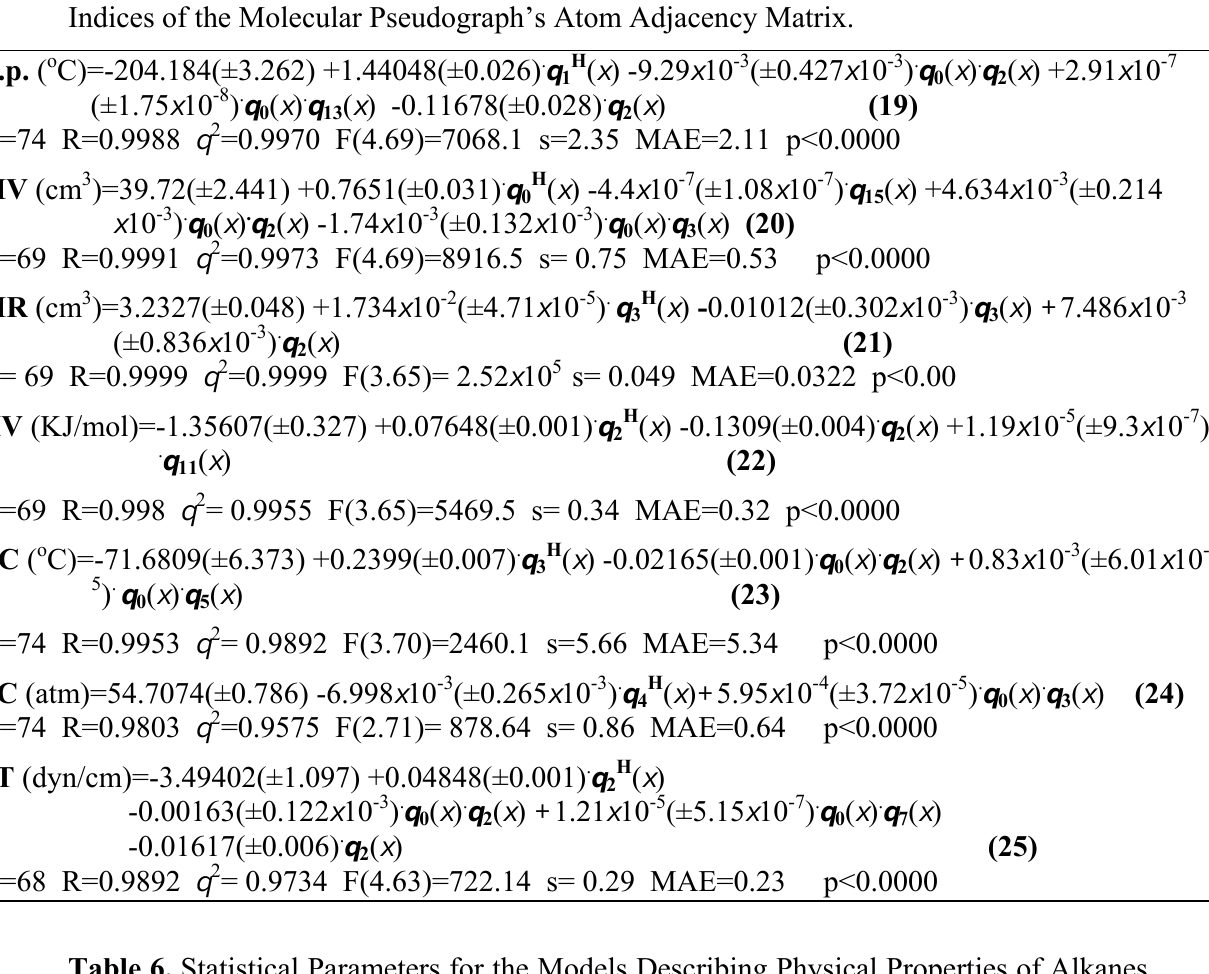
Table 5. Multiple Regression Equation for Physical Properties Using the Quadratic Indices of the Molecular Pseudograph(cid:146)s Atom Adjacency Matrix.